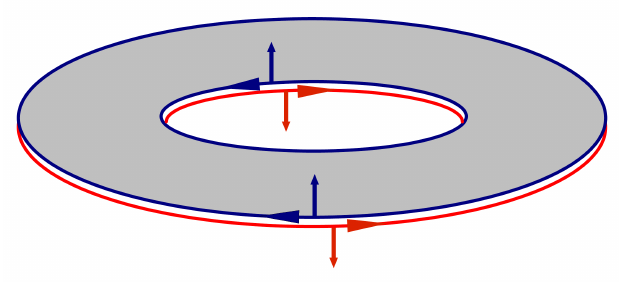
Figure 13: Edge excitations in the quantum spin Hall effect. On the outer edge, right-moving spin-down modes are drawn in red, left-moving spin-up ones in blue. Velocities are reversed in the inner